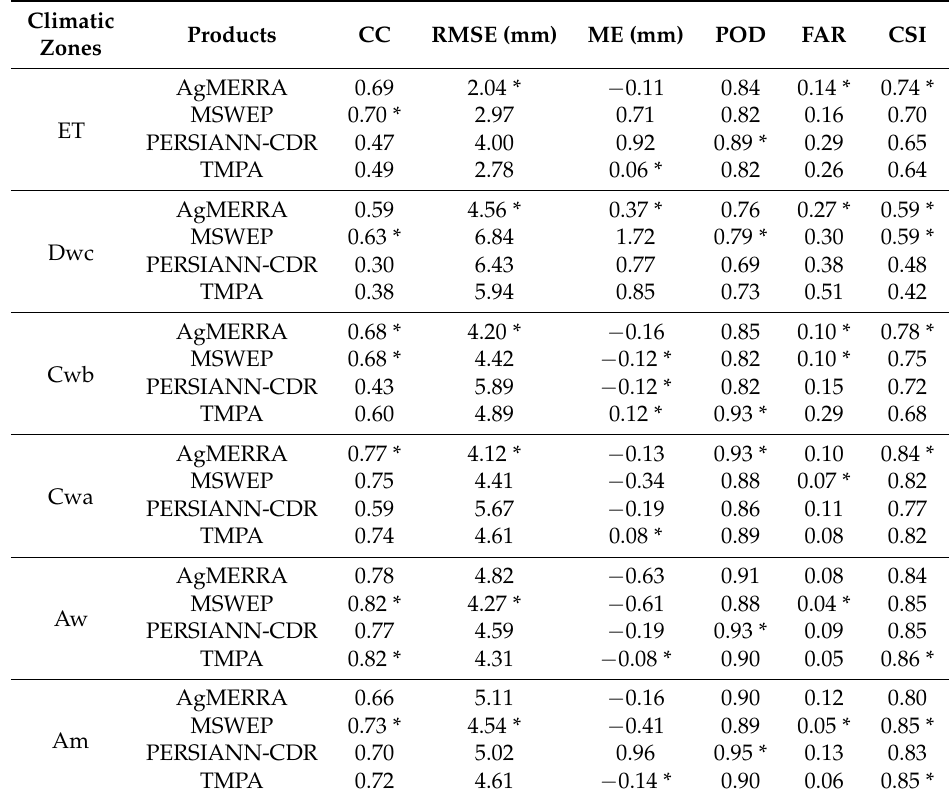
Table 4. List of evaluation metrics for AgMRRA, MSWEP, PERSIANN-CDR, and TMPA with gauge observations at daily resolution over six different climatic zones in MRB. The threshold for the occurrence of rainfall events is daily precipitation greater than 0.1